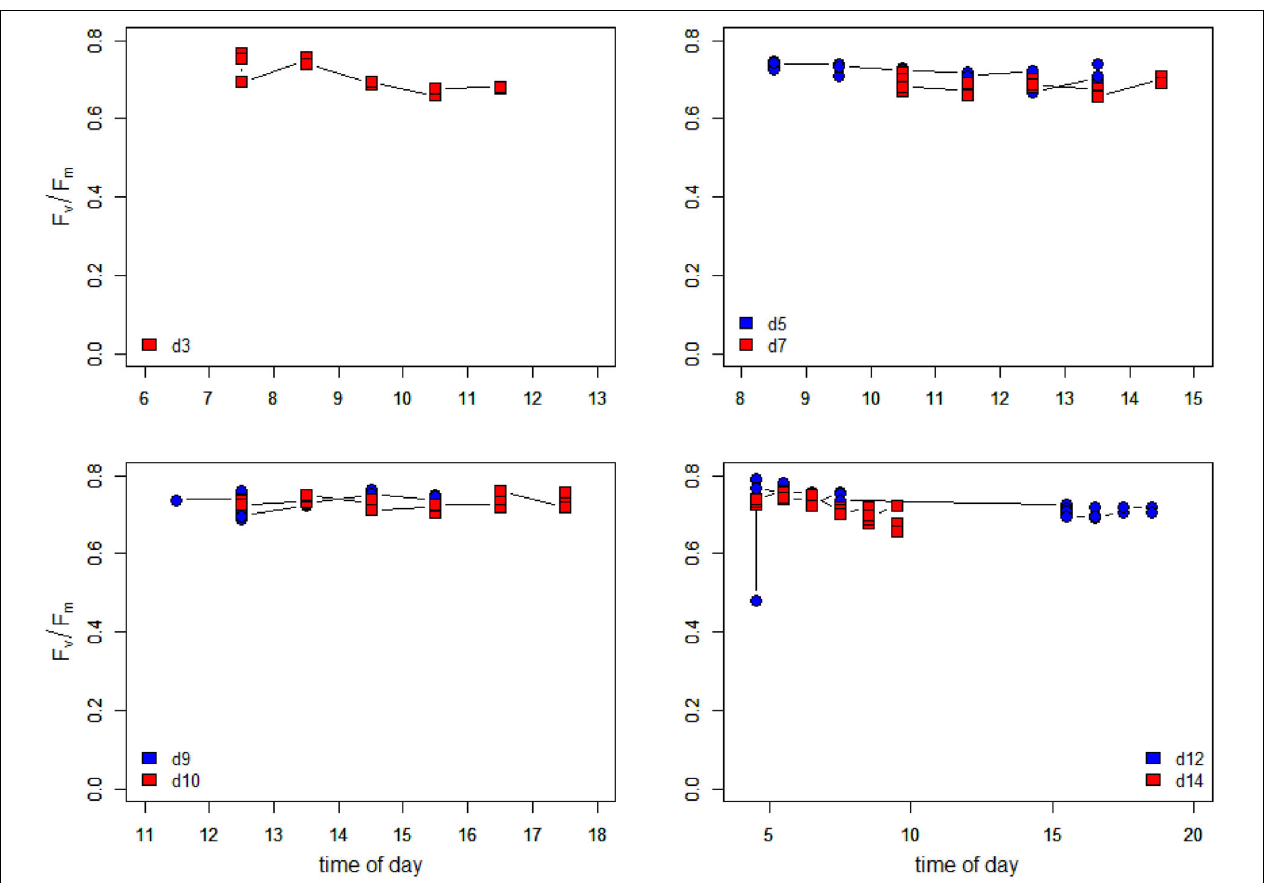
FIGURE 9 | Changes in the maximum PSII efficiency (dark-acclimated F v /F m ) during the days of the measurements. Data are the average of hourly time